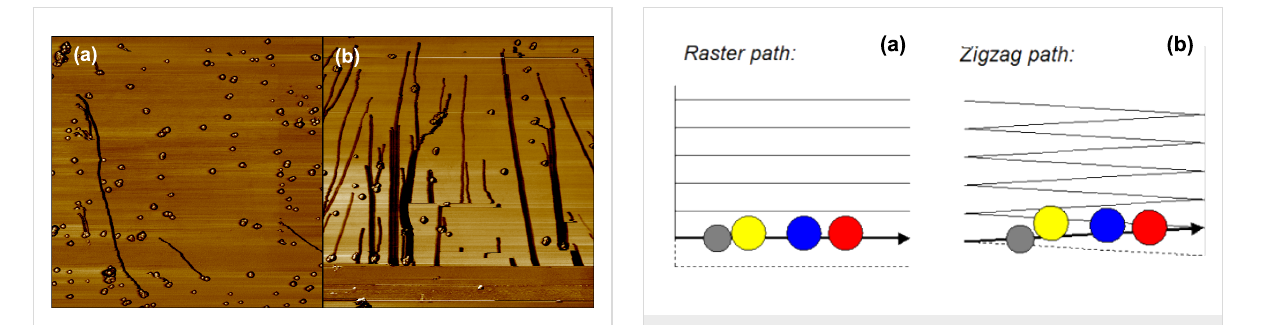
Figure 3: Typical scan patterns used in AFM: (a) raster scan path used by Nanosurf (b) zigzag scan path used by Veeco. Top view: the grey disk corresponds to the position of the tip on the surface and the yellow, blue and red disks are the positions of spherical particles pushed by the tip along its scan